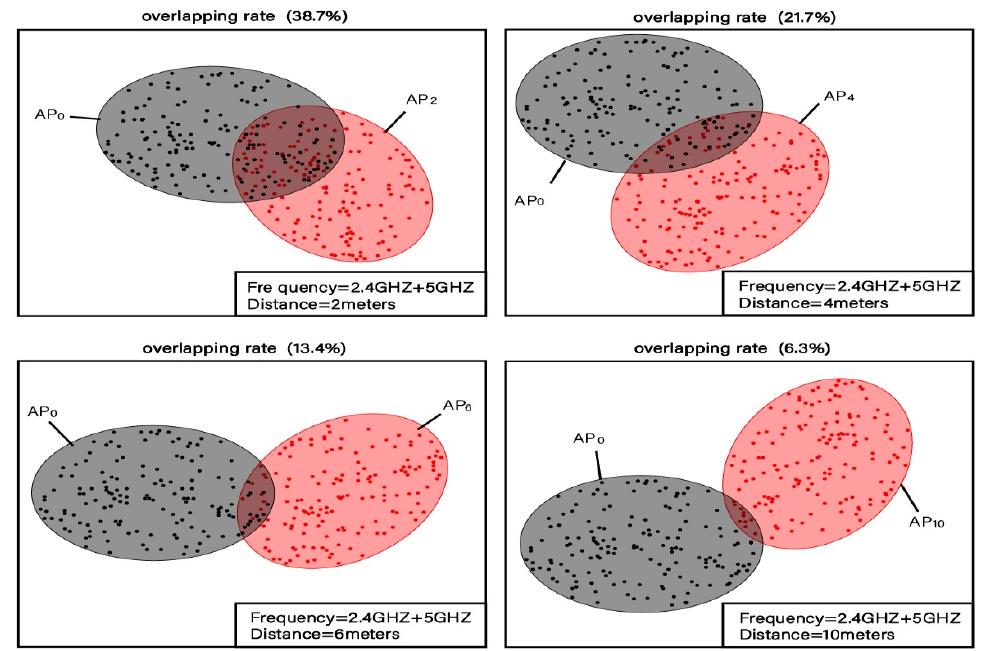
Figure 4. Distinguishability of 2.4G and 5G four-dimensional fingerprint data clustering intervals of reference points at adjacent positions.